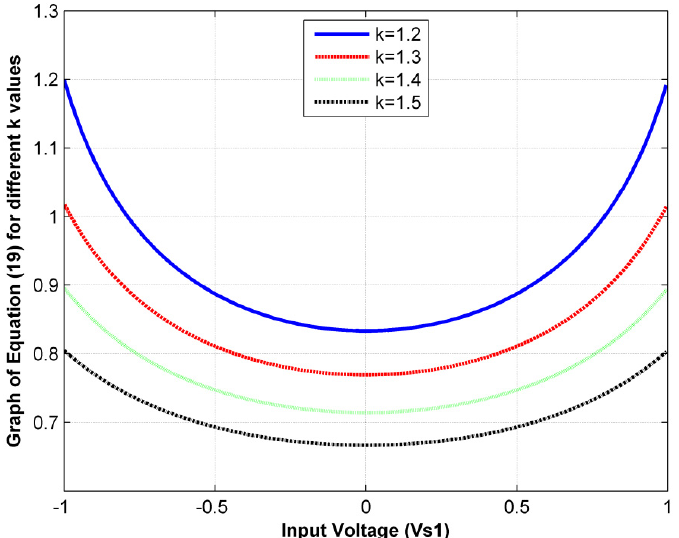
Figure 6. Graph of the Equation (19) for different k values. Note that as k increases the lines